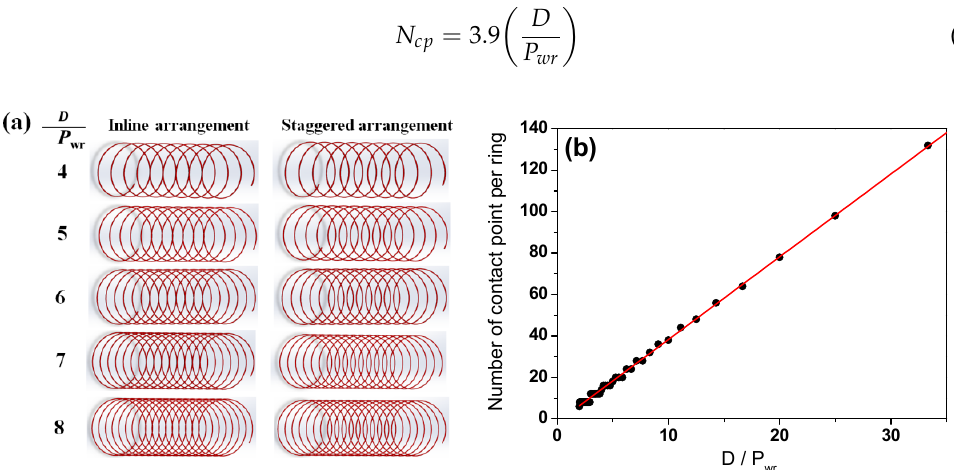
Figure 14. Calculated ( a ) projection area of wire ring with wire position and ( b ) hotspot indicator as a function of wire diameter and wire position during Stelmor cooling.